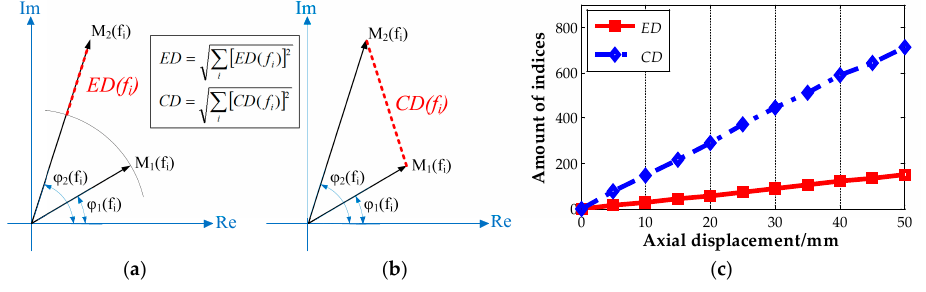
Figure 14. ( a , b ) The i th samples of the new and the fingerprint frequency response in the complex plane. M and ϕ corresponds to the magnitude and phase values of a sample; and ( c ) comparison of the two indices for different amounts of axial displacements [35].